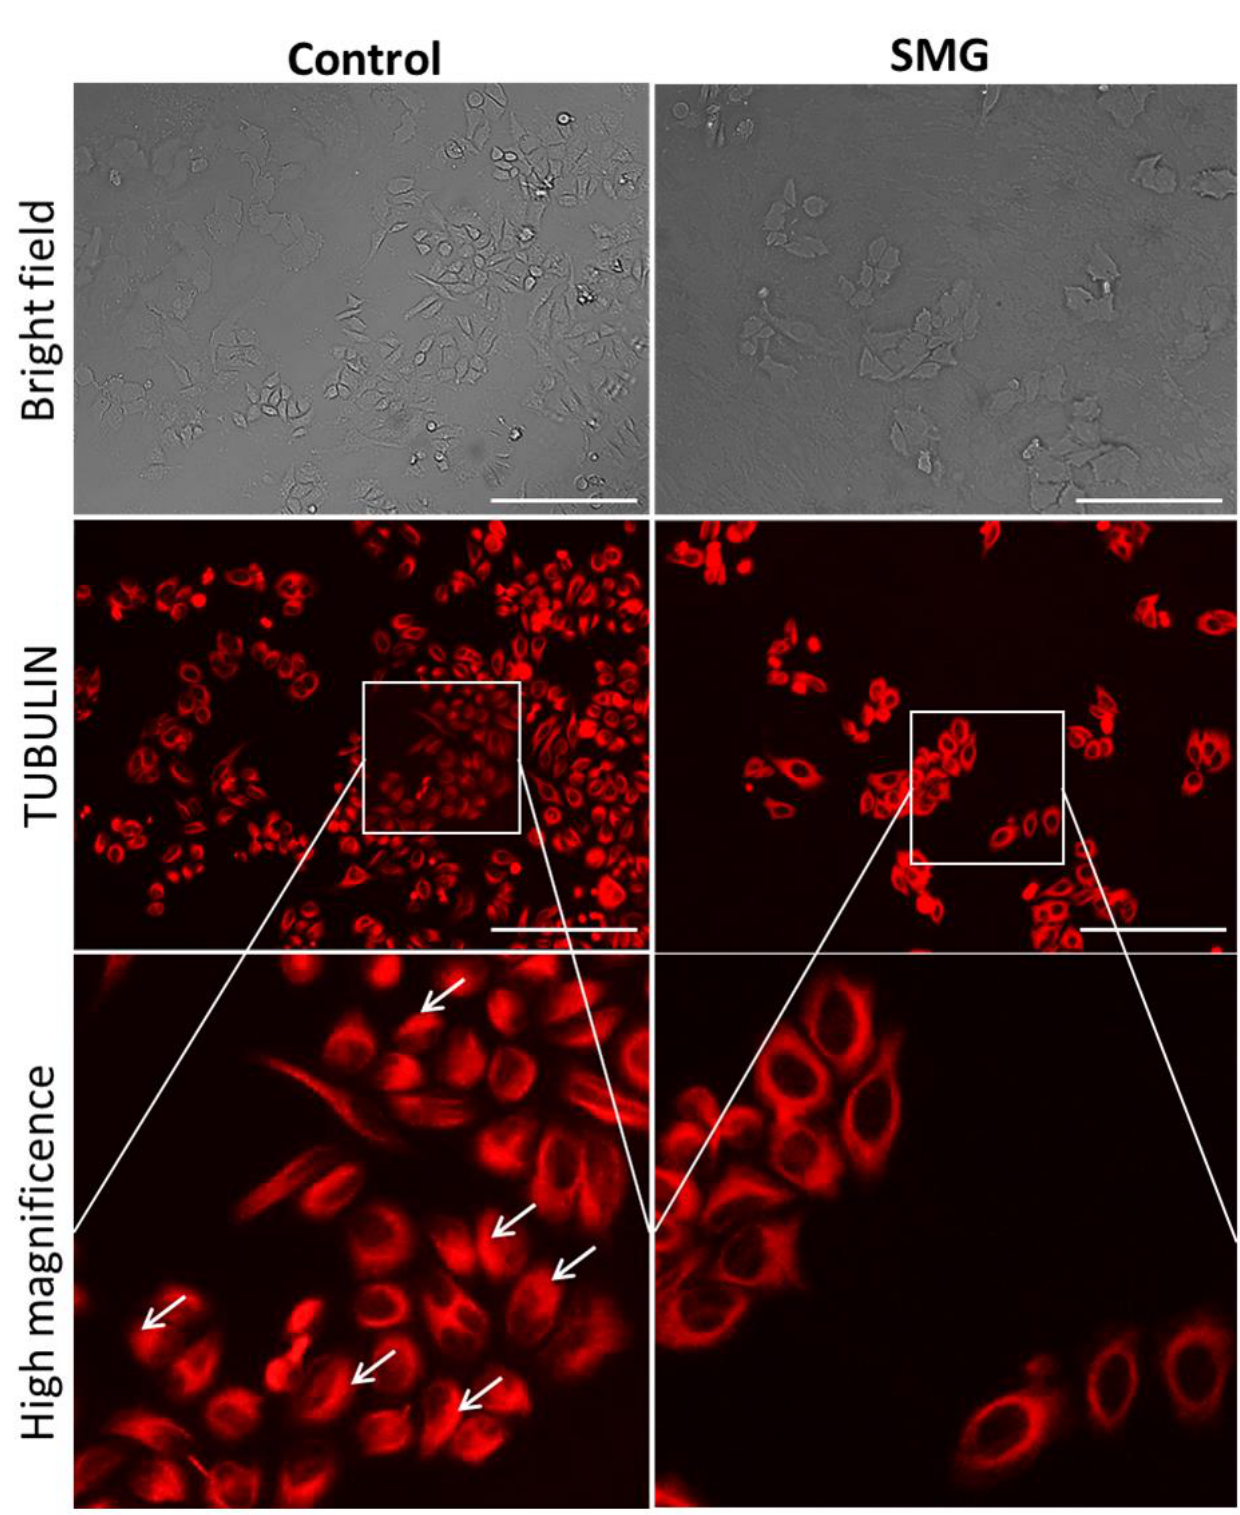
Figure 5. Distribution of microtubules in CCL-13 cells. Microtubules were stained with Sir-Tubulin (red). The white arrows indicate perinuclear accumulation of microtubules. Scale bar = 223.64 µm.